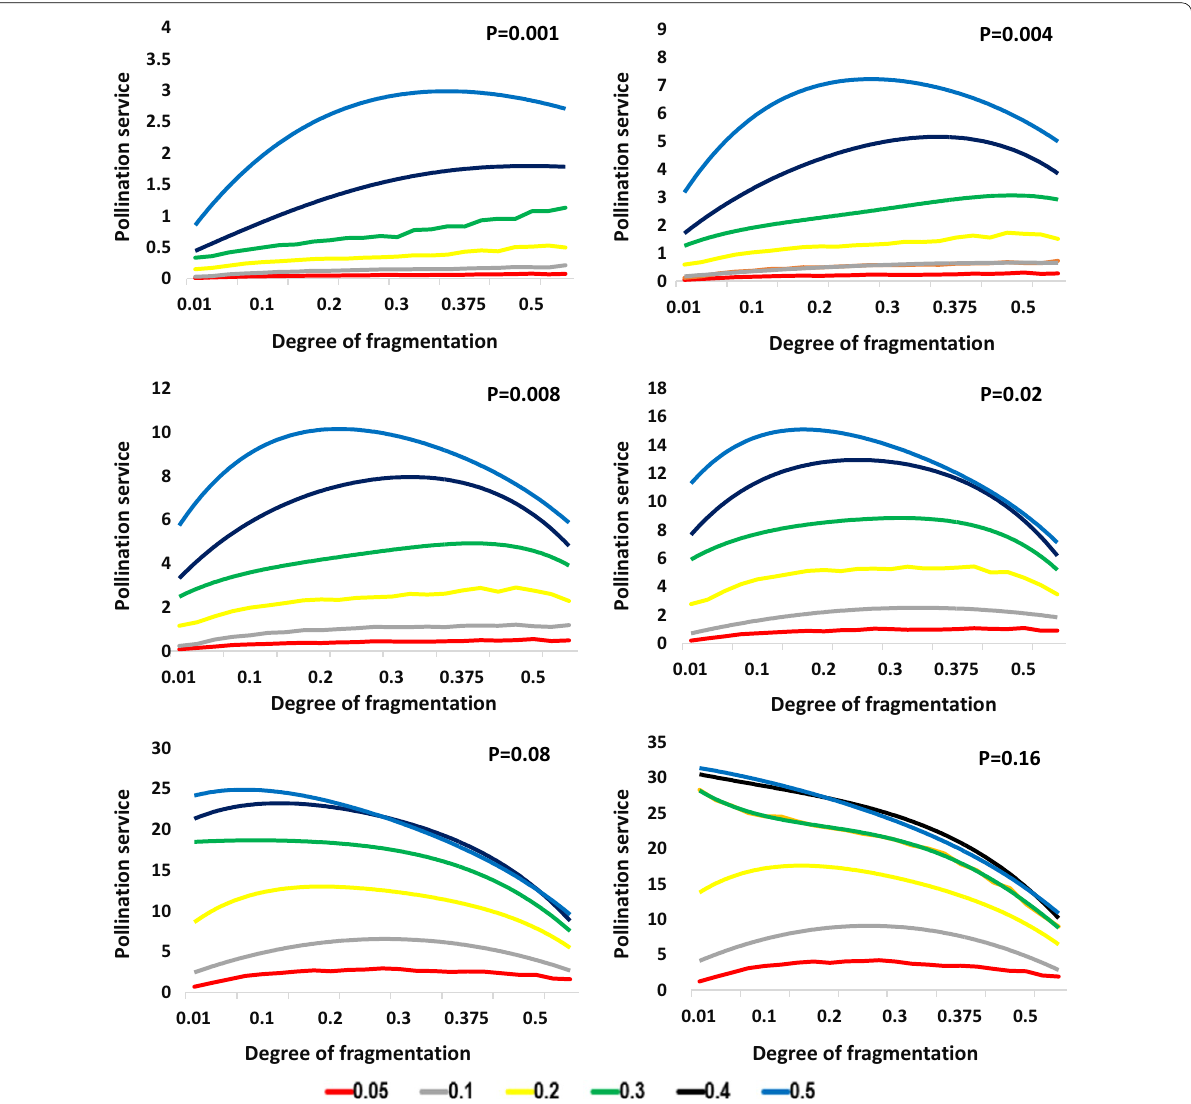
Fig. 2 Pollination shifts according to forest fragmentation level and small patches’ capacity in supplying pollination. In this figure, horizontal axes show the degree of fragmentation and vertical axes indicate estimated pollination at the farm level. Fragmentation decreases the pollination services at p 0.001 while it increases pollination at higher p values. The shift in the position of the maximum level of pollination from p = p 0.16 is =